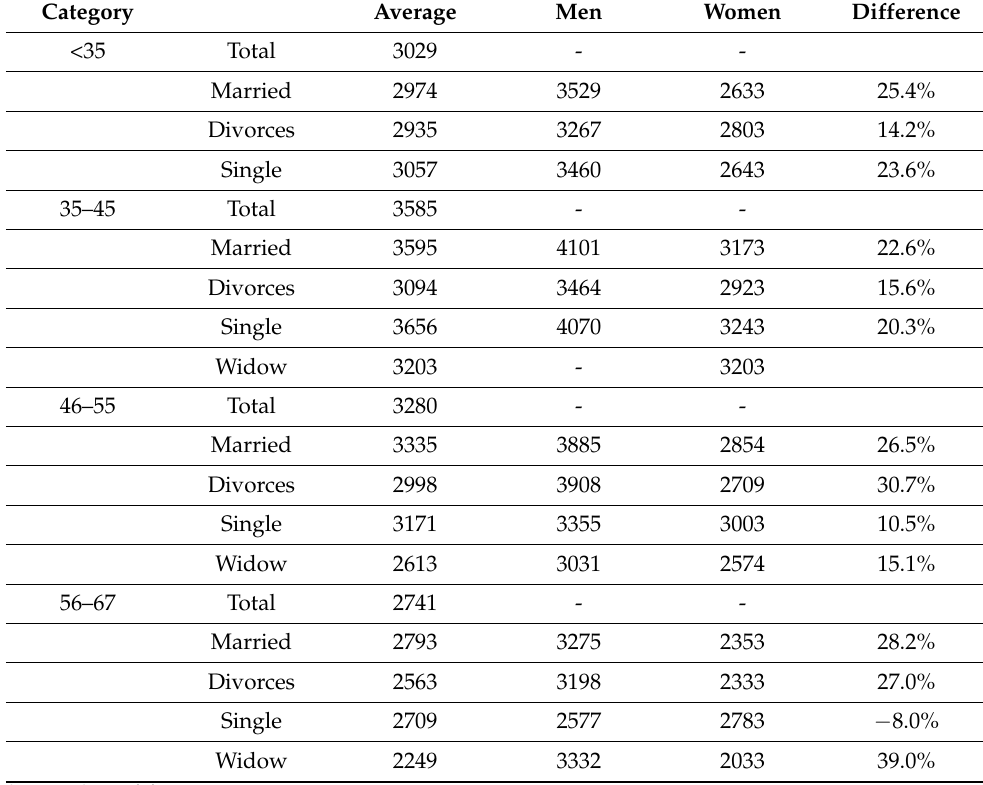
Table 1. Sample’s wage distribution